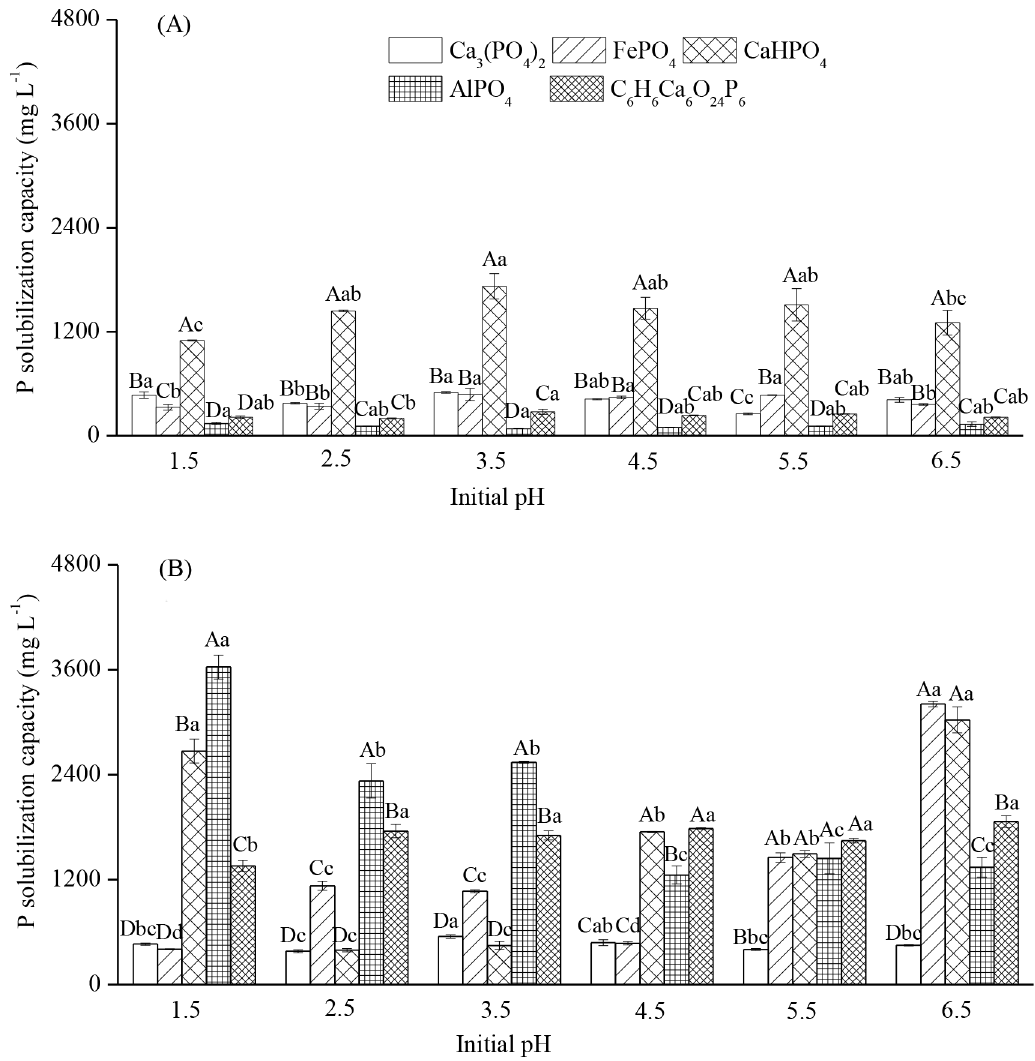
Fig 4. The solubilizing capacity of five P sources under different initial pH of TalA-JX04 (A) and AspN-JX16 (B). Note: Value = Mean ± standard error. The uppercase indicated the differences ( p < 0.05) among the five P sources within same initial pH and the lowercase indicated the differences ( p < 0.05) among the initial pH within the same P